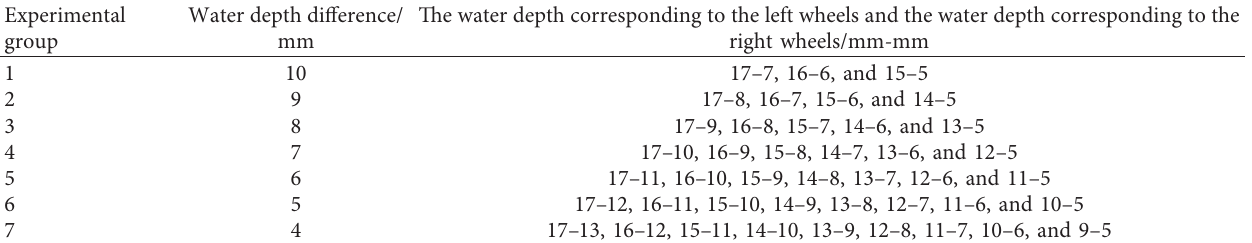
Table 1: Settings of left and right rut water depths.